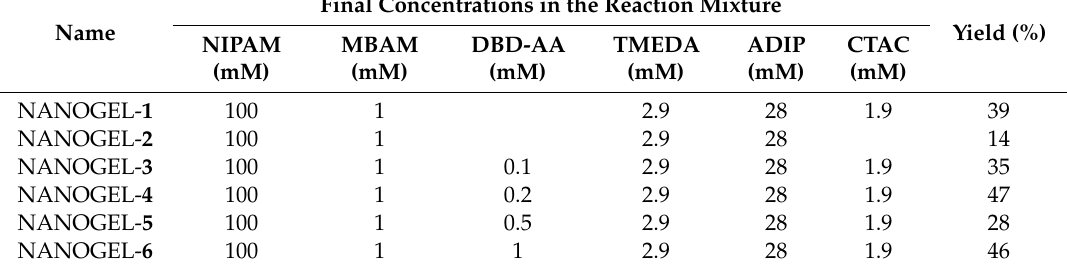
Table 1. Preparation of cationic nanogels (NANOGEL- 1 and NANOGEL- 2 ) and cationic fluorescent nanogel thermometers (NANOGEL- 3 ~ 6